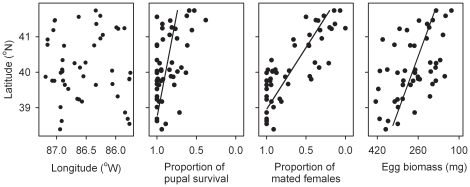
Female fitness in 2009.Spatial distribution of host plants of bagworms, Thyridopteryx ephemeraeformis, sampled in Indiana to determine multiple components of female fitness during the 2009 bagworm generation (Table 1). Latitude (x) significantly affected proportions of pupal survival [linear model with 50 sites, y = 4.33−0.086 x, r2 = 0.257, P = 0.0002] and of mated females [linear model with 50 sites, y = 12.2−0.29 x, r2 = 0.655, P<0.0001], as well as fecundity [linear model with 49 (excluding one site with no egg mass sampled), y = 2315−50.8 x, r2 = 0.305, P<0.0001].